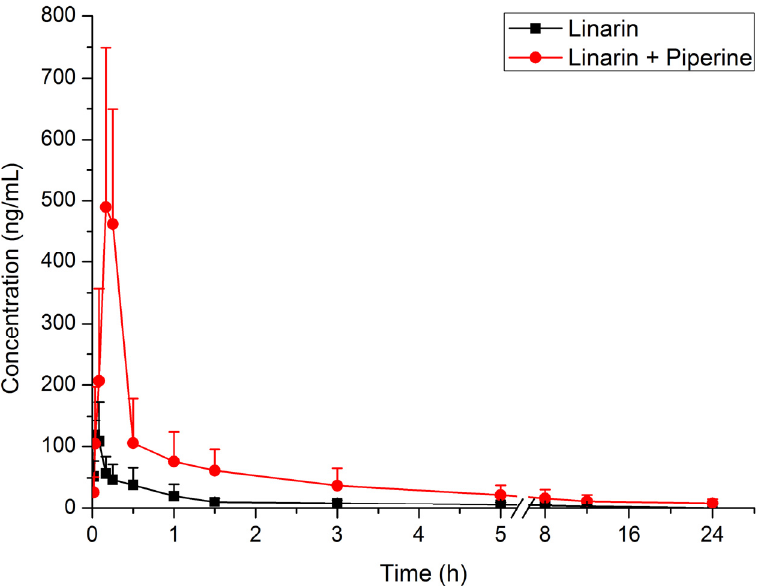
Figure 3. Mean plasma concentration–time curves of linarin in rats following oral administration of linarin alone and in combination with piperine ( n = 5).